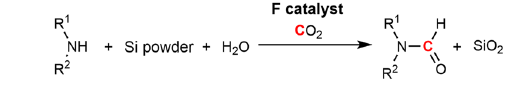
Fig. 2 Reductive CO 2 functionalization using waste Si and amines. Fluoride catalysis for this reaction was